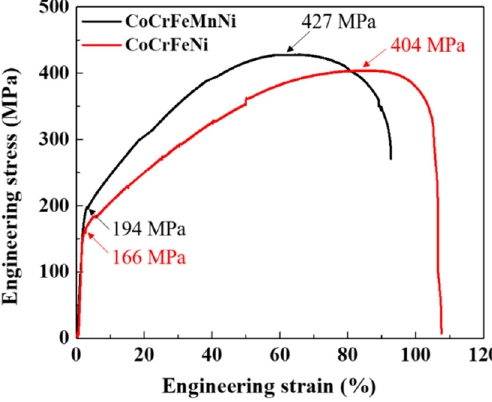
Figure 1. Engineering stress–strain (S-S) curves of the CoCrFeNi and CoCrFeMnNi alloys.